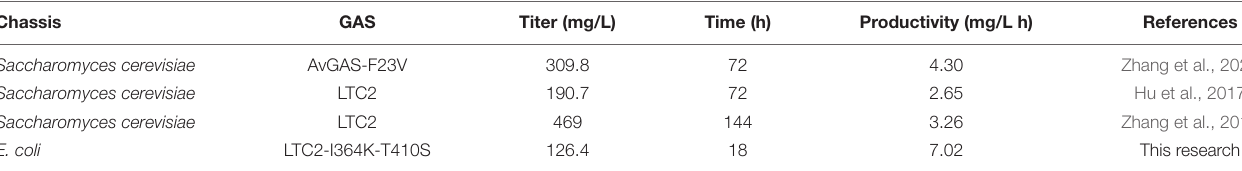
TABLE 3 | Comparison of data for the production of β -elemene in engineered strains. Chassis GAS Titer (mg/L) Time